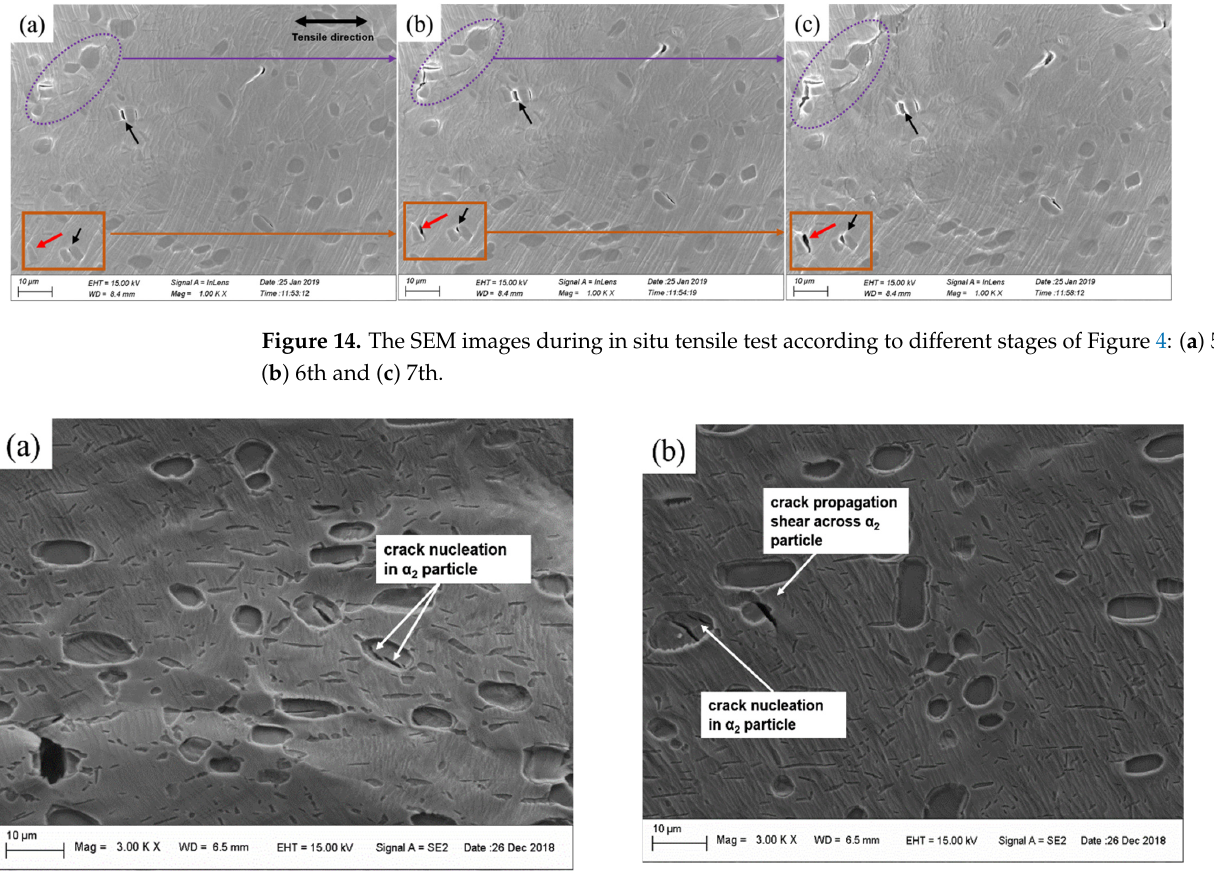
Figure 16. The schematic diagram of the initiation and propagation of the crack [36].